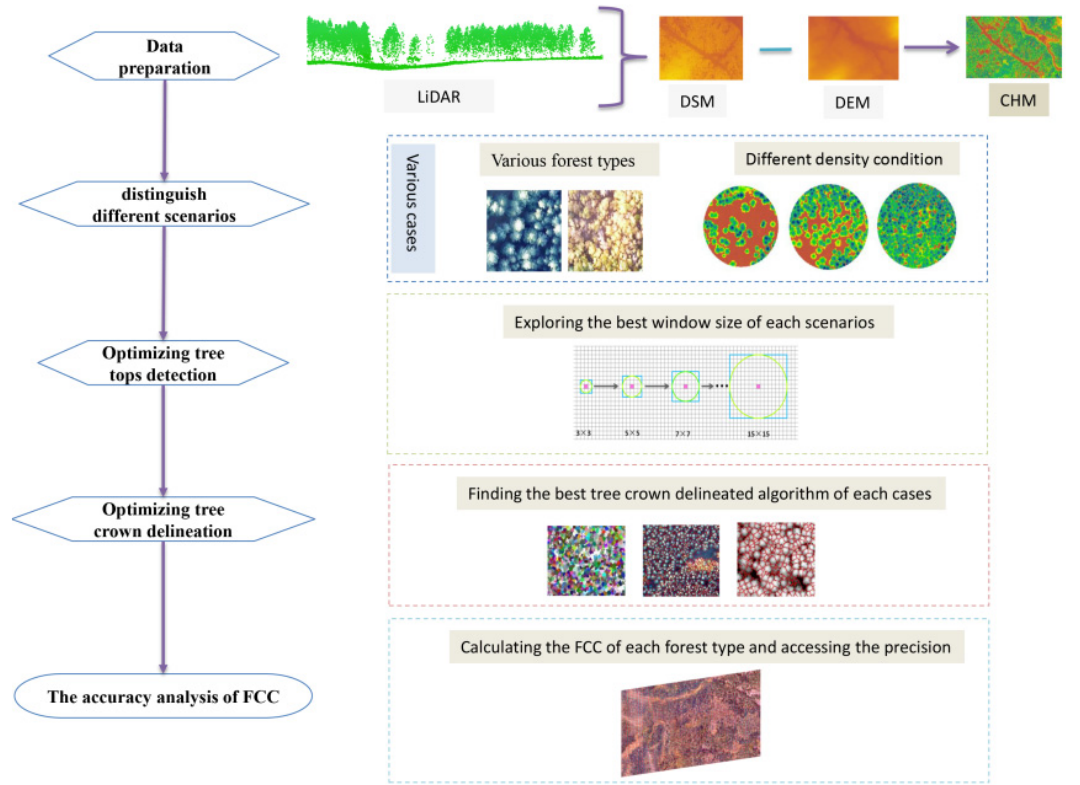
Figure 1. Methodological workflow of FCC estimated. This contains five steps: data preprocess treetop detection, tree-crown delineation, FCC estimation, and accuracy evaluation. This study focuses on six cases involving two tree species, namely camphor and white birch, and three degrees of stands densities, namely sparse area, medium area, and dense area.